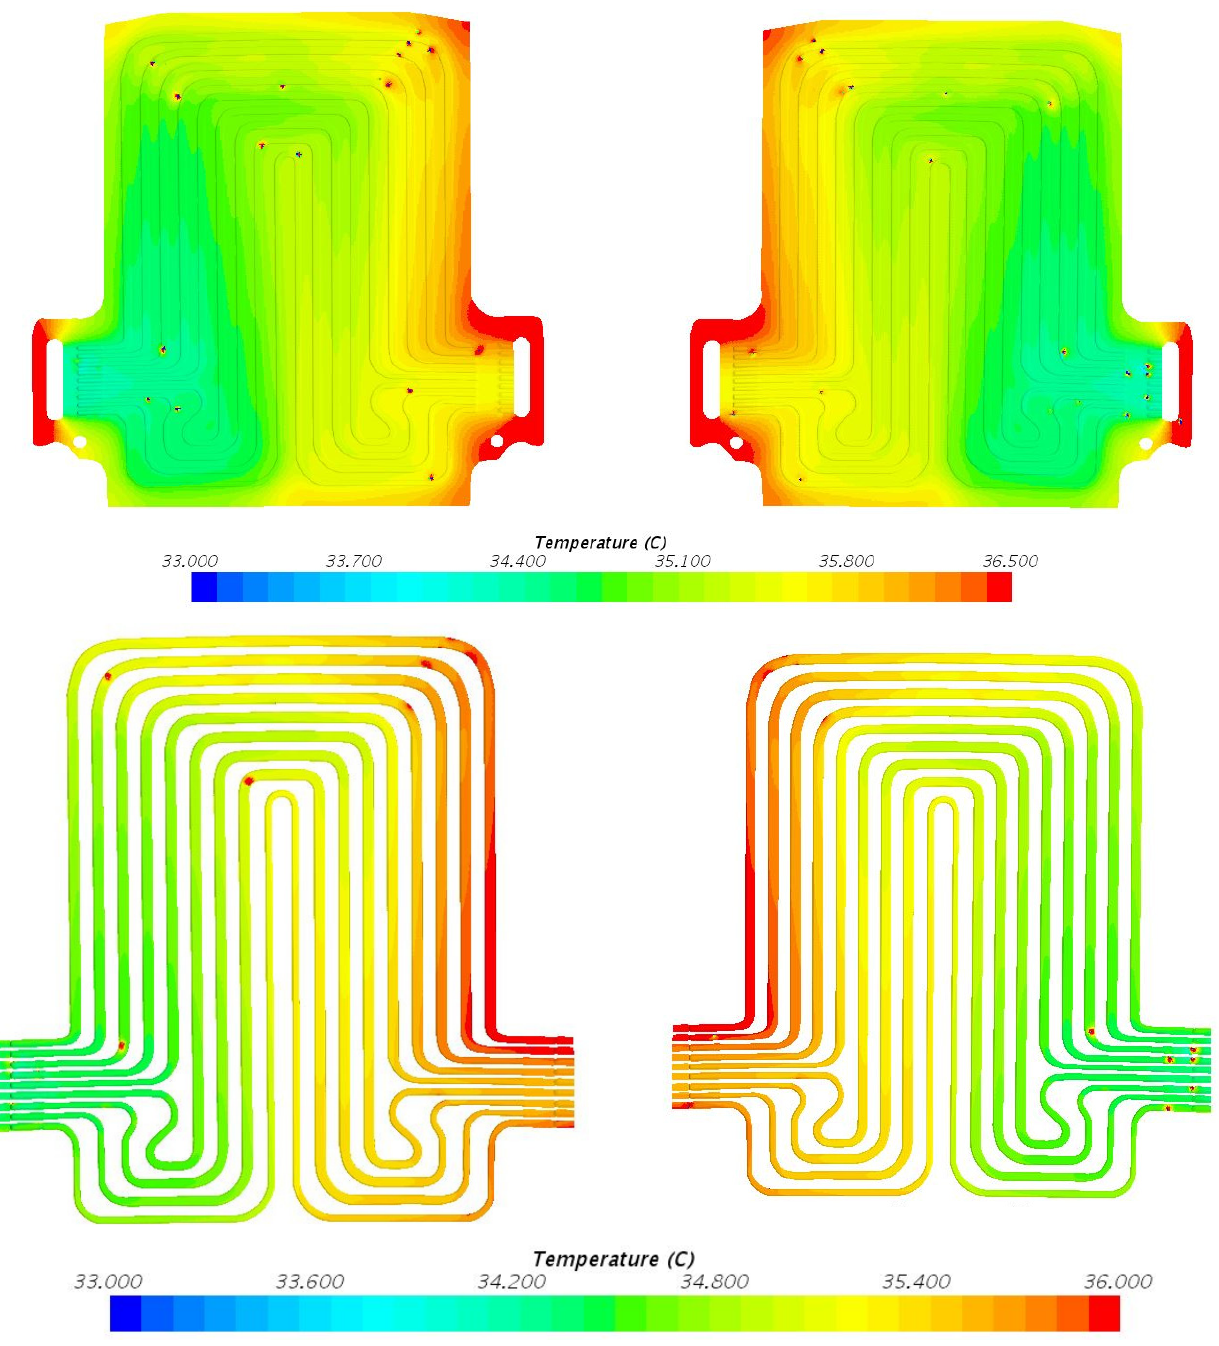
Figure 14. Temperature field at 40 A discharge current and 35 °C coolant inlet temperature, with 2 , position 2 = 689.7 W/m 2 , and position 3 = 163.3 W/m 2 heat flux at position 1 = 585.6 W/m 2 , position 2 = 689.7 W/m 2 , and position 3 = 163.3 W/m 2 . flux at position 1 = 585.6 W/m